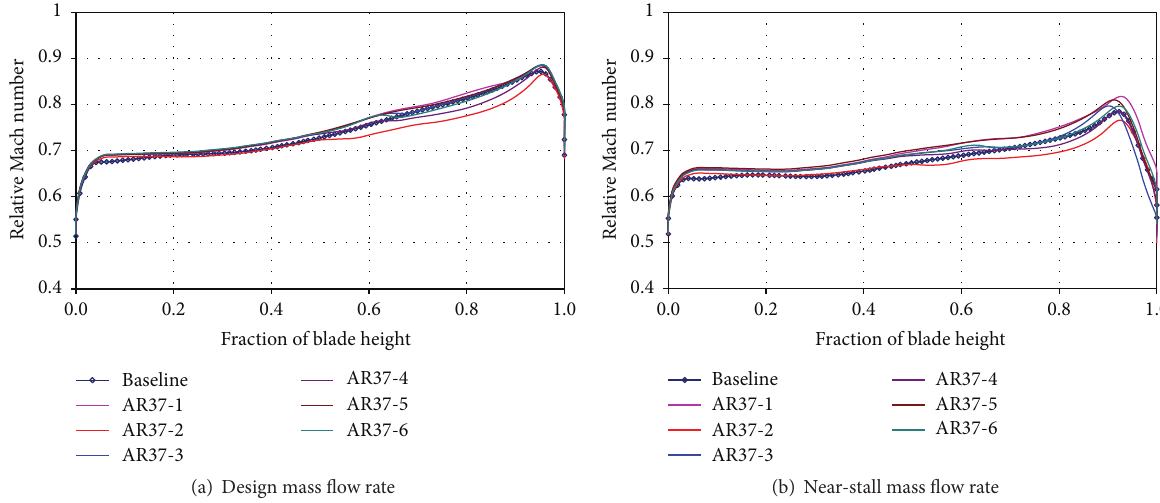
Figure 15: Radial variation of relative Mach number at exit to rotor for different aspiration slot configurations (100% design rotational